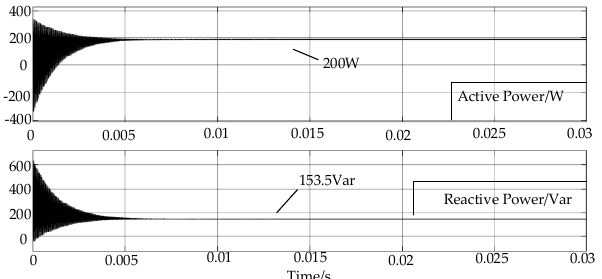
When the full-arm ZVS is realized, the resonant current turns from negative to positive after the A-arm drain-source voltage drops to 0. After the B-arm drain-source voltage drops to 0, the resonant current is at the positive to negative boundary, and the B-bridge arm is at the soft-switching boundary at this time. After the C-bridge arm drain-source voltage drops to 0, the transformer secondary current turns from negative to positive. In the ZVS range of the full-bridge arm, a combination of phase-shift angles with the same power and gain was randomly selected and the phase-shift angle ( ϕ AD = 63 ◦ , ϕ AB = 202.57 ◦ ) was chosen to compare the reactive power values, as shown in Figure 30.